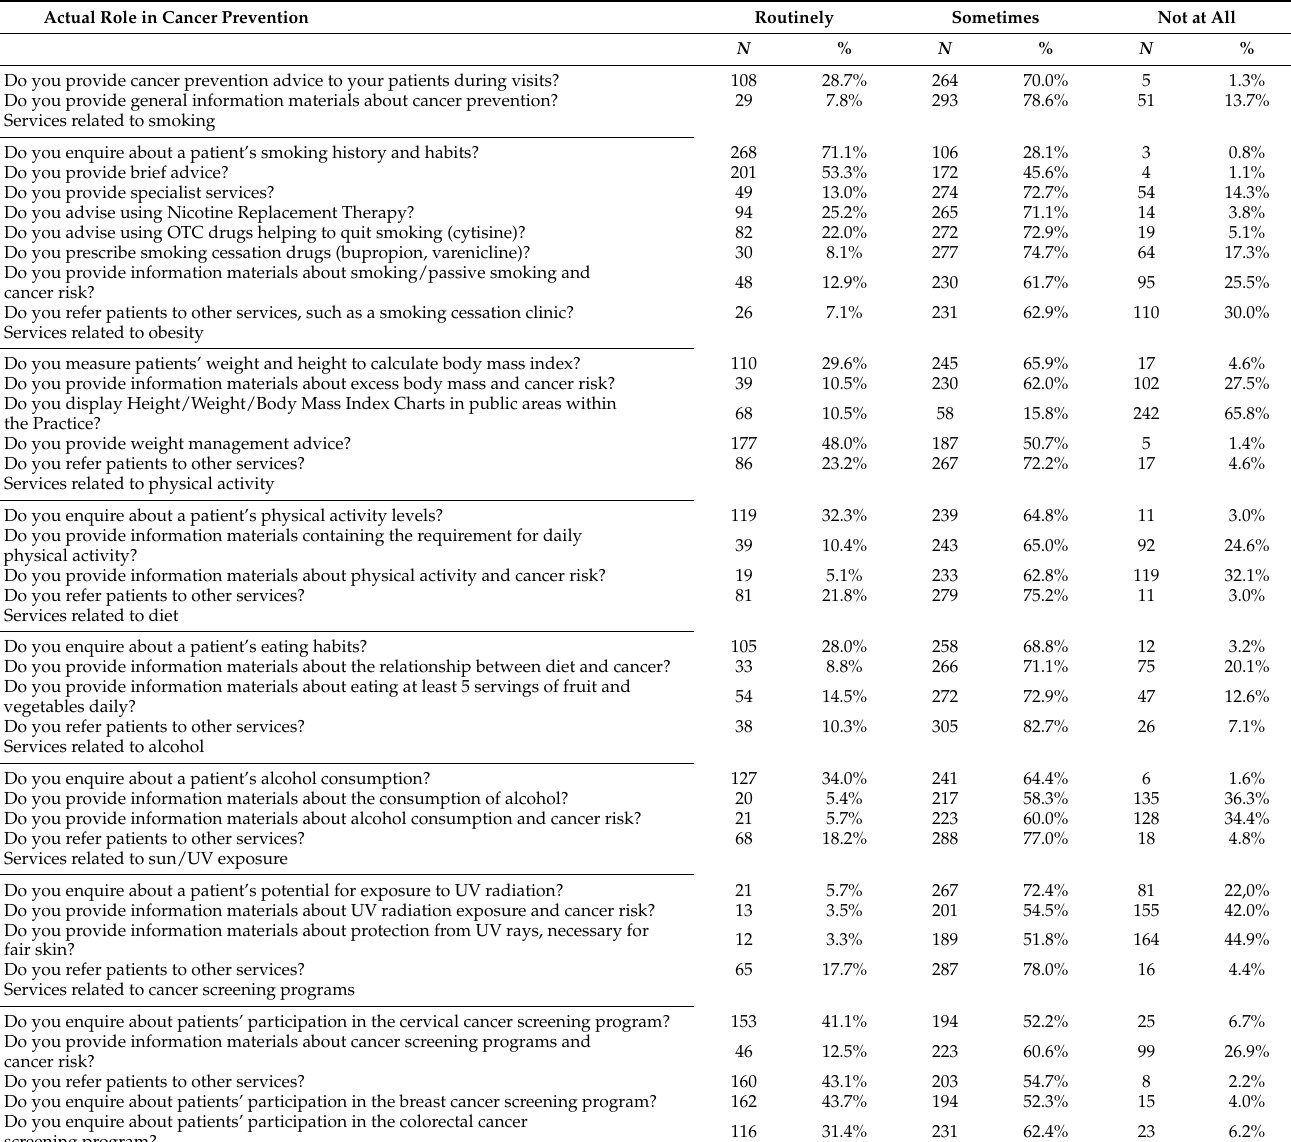
Table 2. Actual role in cancer prevention by chosen risk